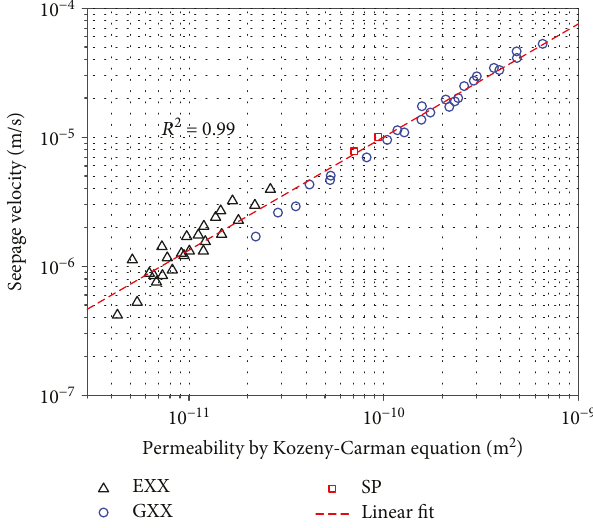
Figure 5: Seepagevelocityas functionofpermeability.Porous media generated by exponential and Gaussian variogram models are named EXX and GXX (black triangles and blue circles,